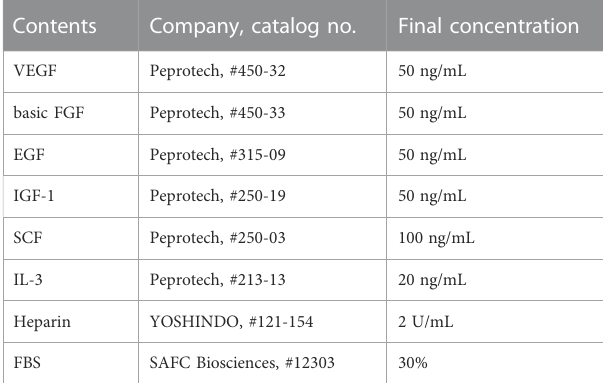
TABLE 3 Contents of semisolid culture medium used for